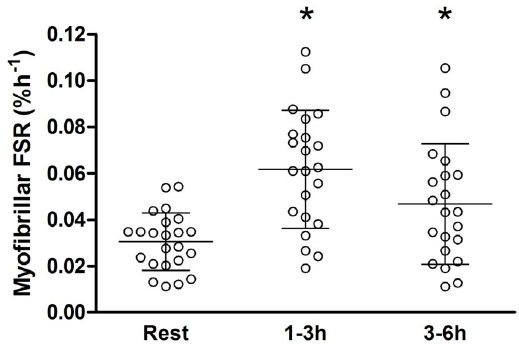
Figure 2. Phosphorylation of anabolic signalizing proteins. The results are expressed as fold changes from rest at 1, 3 and 6 hours after an acute bout of resistance exercise prior to the training period. All changes are normalized to alpha tubulin. A) mTOR phosphorylation at Ser2448, B) Akt phosphorylation at Ser473, C) 4E-BP1 phosphorylation at Thr37/46 and D) rpS6 phosphorylation at Ser240/244. * Significantly different from rest P , 0.05. { Signficantly different from 1 and 3 hour time points P ,